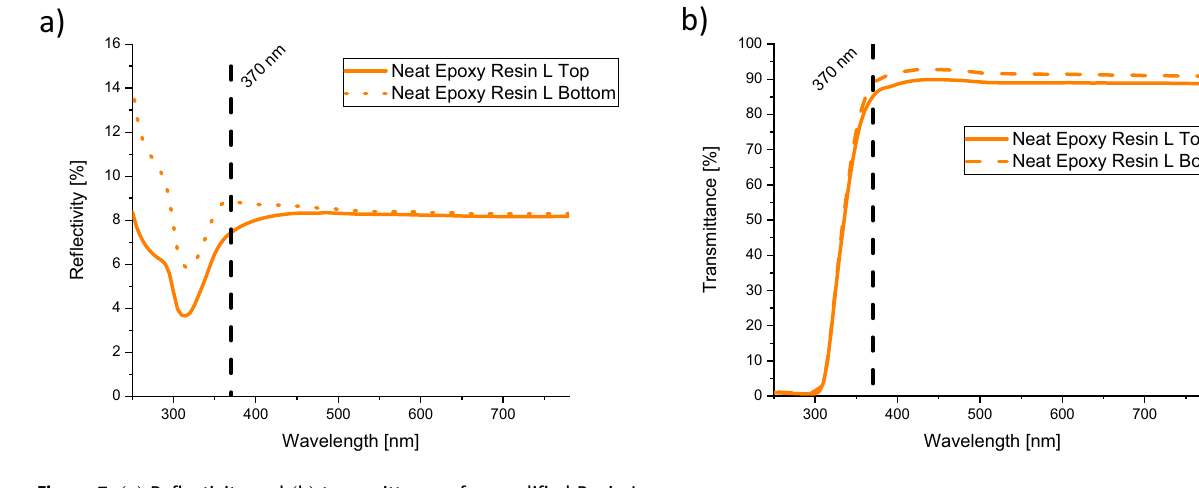
Figure 7: ( a ) Re fl ectivity and ( b ) transmittance of unmodi fi ed Resin